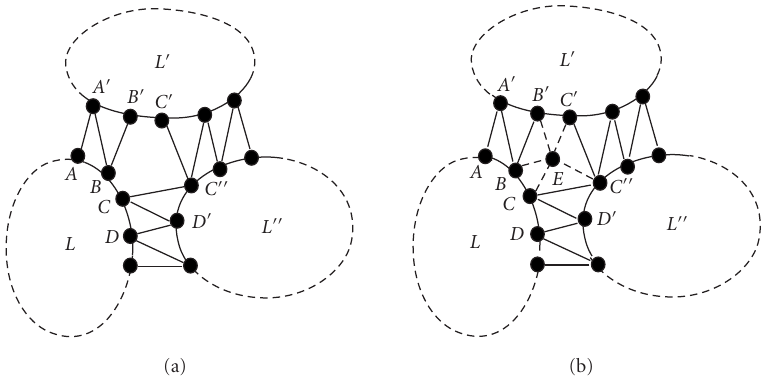
Figure 1: Multiple-contours stitching. (a) New triangles are created by connecting corresponding vertices between di ff erent linked lists. A gap that consists of vertices B , C , C (cid:5)(cid:5) , C (cid:5) , and B (cid:5) is generated and need to be filled in. (b) The gap is filled in by creating a new vertex E in the center and connecting it with all other vertices in the gap.